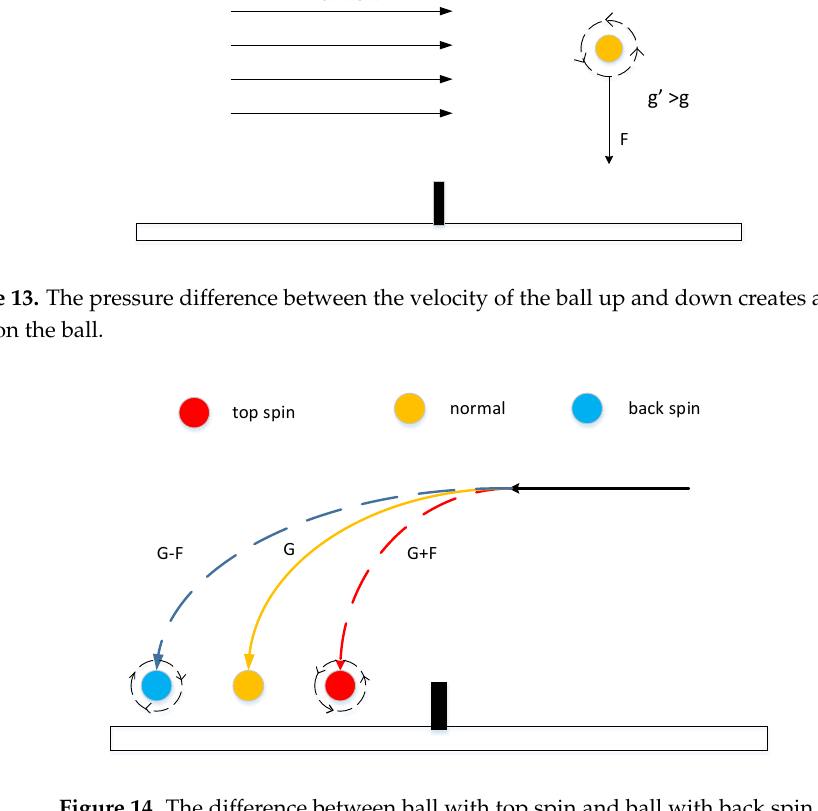
Figure 14. The difference between ball with top spin and ball with back